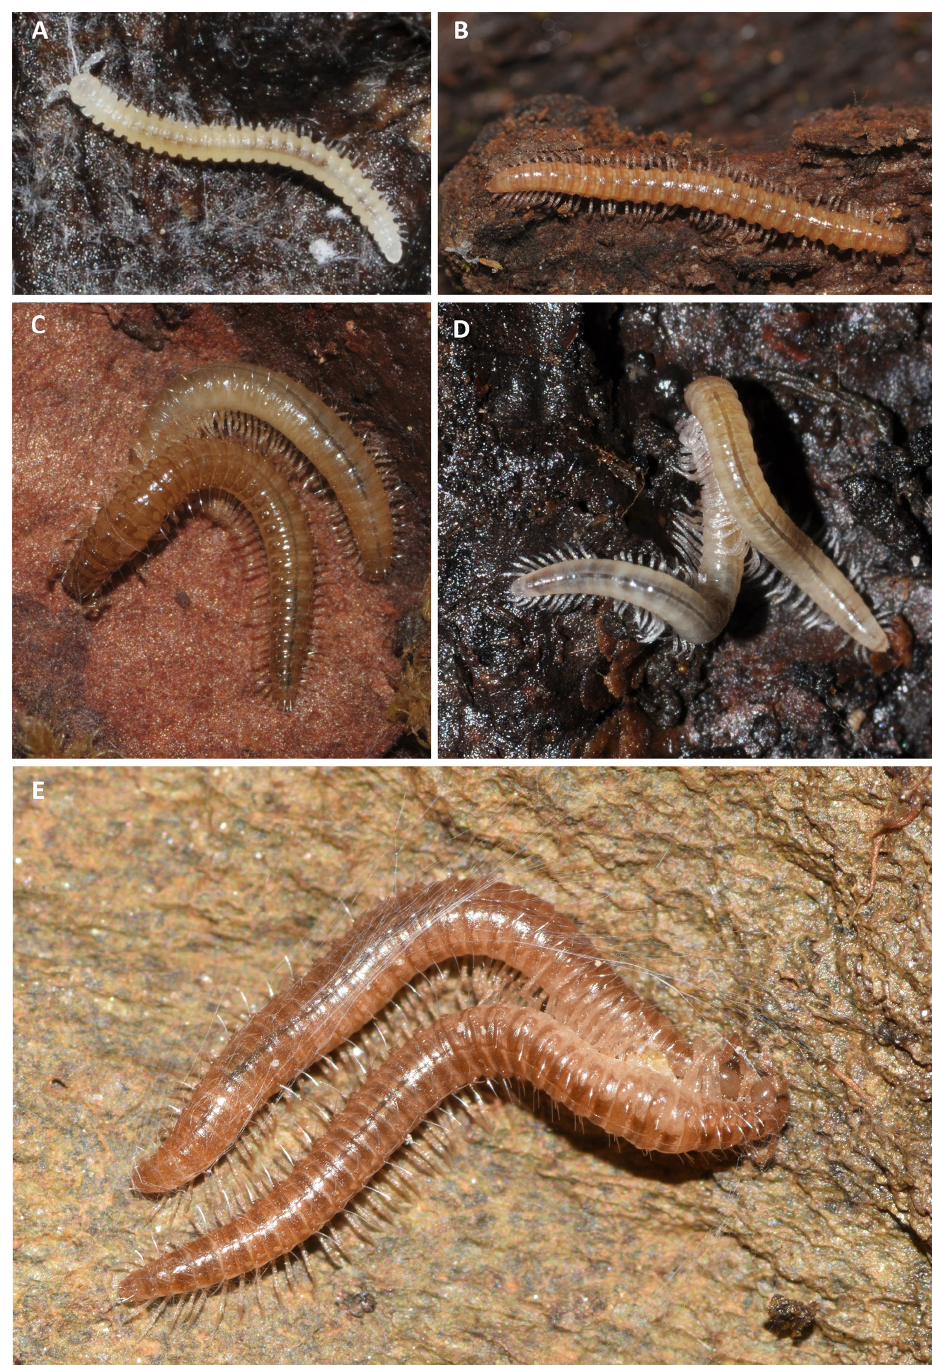
Fig. 2. A selection of European species of Chordeumatida C.L. Koch, 1847, various families. A . Halleinosoma noricum Verhoeff, 1913 (Trachygonidae Cook, 1896). B . Syngonopodium aceris Verhoeff, 1913 (Attemsiidae Verhoeff, 1899). C . Xylophageuma zschokkei Bigler, 1912 (Haaseidae Attems, 1899), in copula. D . Haplogona oculodistincta (Verhoeff, 1893) (Verhoeffiidae Verhoeff, 1899), in copula. E . Haasea fonticulorum (Verhoeff, 1910) (Haaseidae), in copula . Jörg Spelda has pointed out that on Figs 2C and 2E, both showing copulation in species of Haaseidae, the female is seen to be partially covered in a fine web (most evident in Fig. 2E), probably produced by the male’s spinning glands and perhaps serving to ‘strap down’ the female to the ground. Photo credits: Jörg